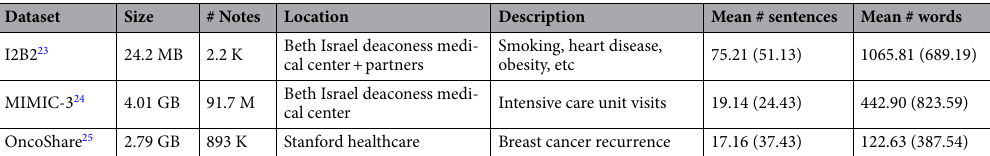
Table 2. A variety of datasets are used to train generable note representations—description and